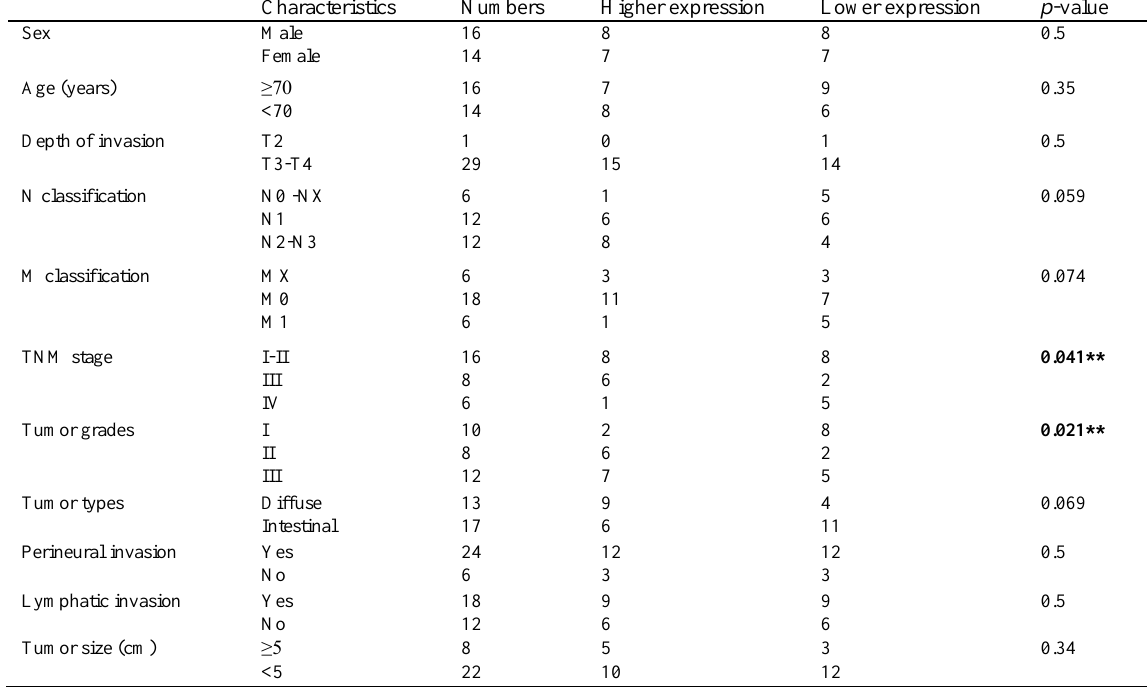
Table 4. Correlation between MVIH expression and clinicopathological parameters of gastric cancer